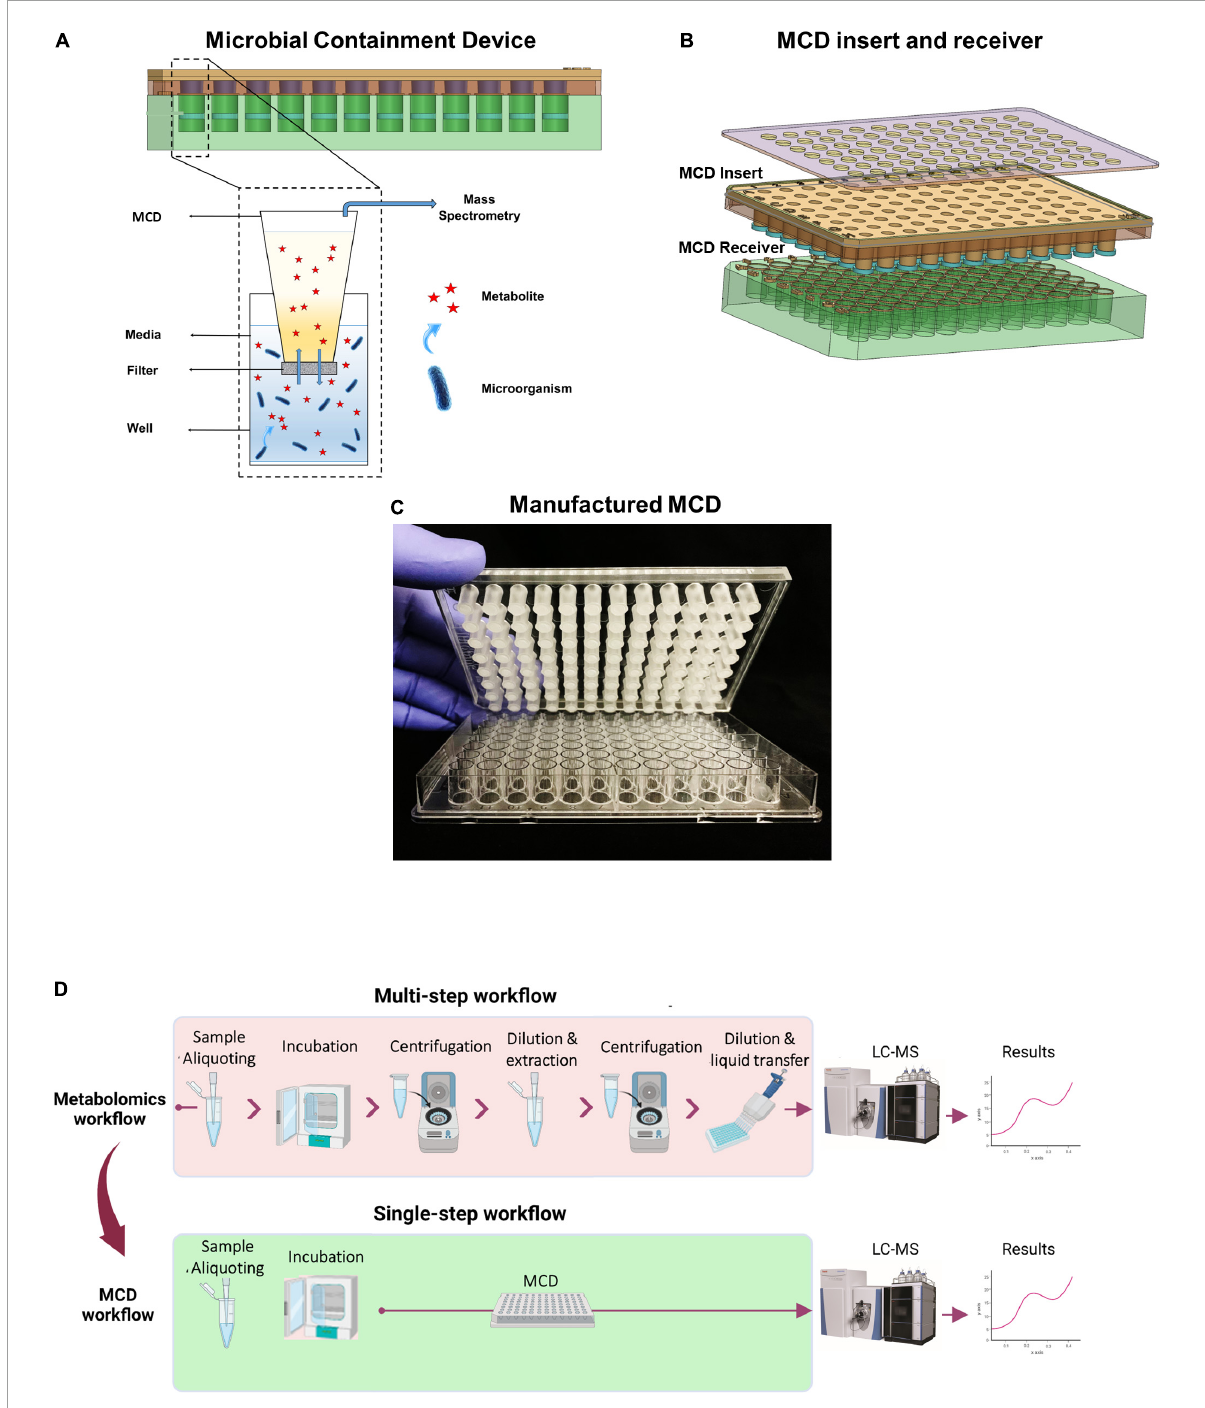
FIGURE1 (A) Schematic view of the MCD design concept, (B) MCD insert and receiver, (C) assembled MCD, and (D) optimized MCD metabolomics workflow, versus conventional metabolomics sample